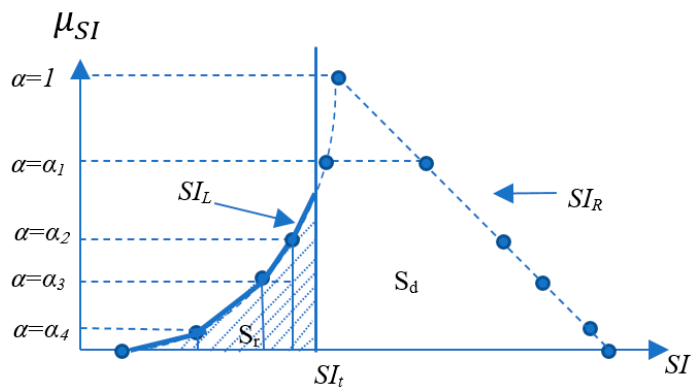
Figure 6. Stability membership function curve.